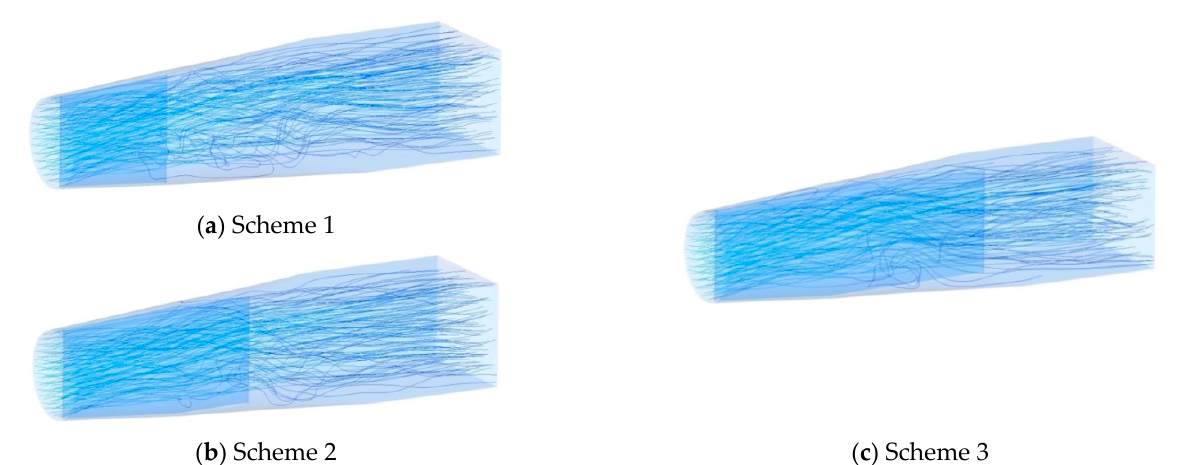
Figure 12. Internal streamline diagram of straight outlet conduit under different design schemes.